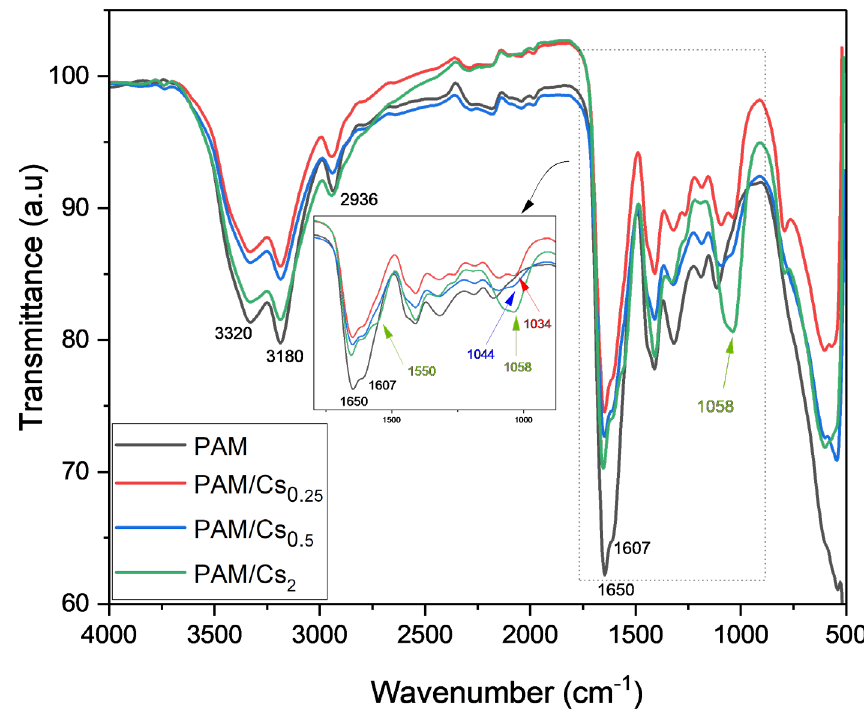
Figure 2. The FTIR spectra of Cs/PAM at various PAM proportions and constant ratio of Cs.